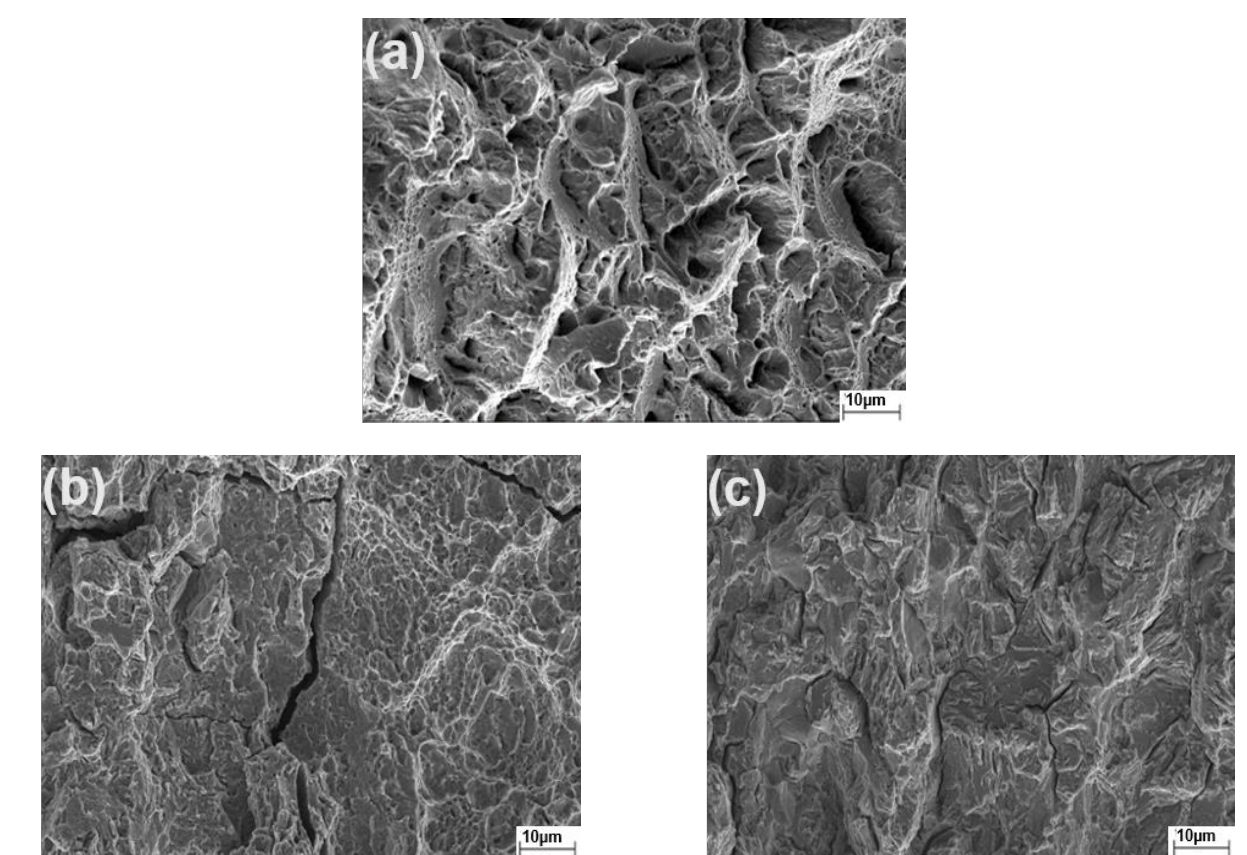
Figure 9. Micrographs of fracture surface for studied steel after CERT with varying hydrogen content: ( a ) In air; ( b ) H-charged to 1.1 wt.ppm corresponding to hydrogen critical concentration; ( c ) H-charged to 4.8 wt.ppm corresponding to the lower plateau on the embrittlement curve.